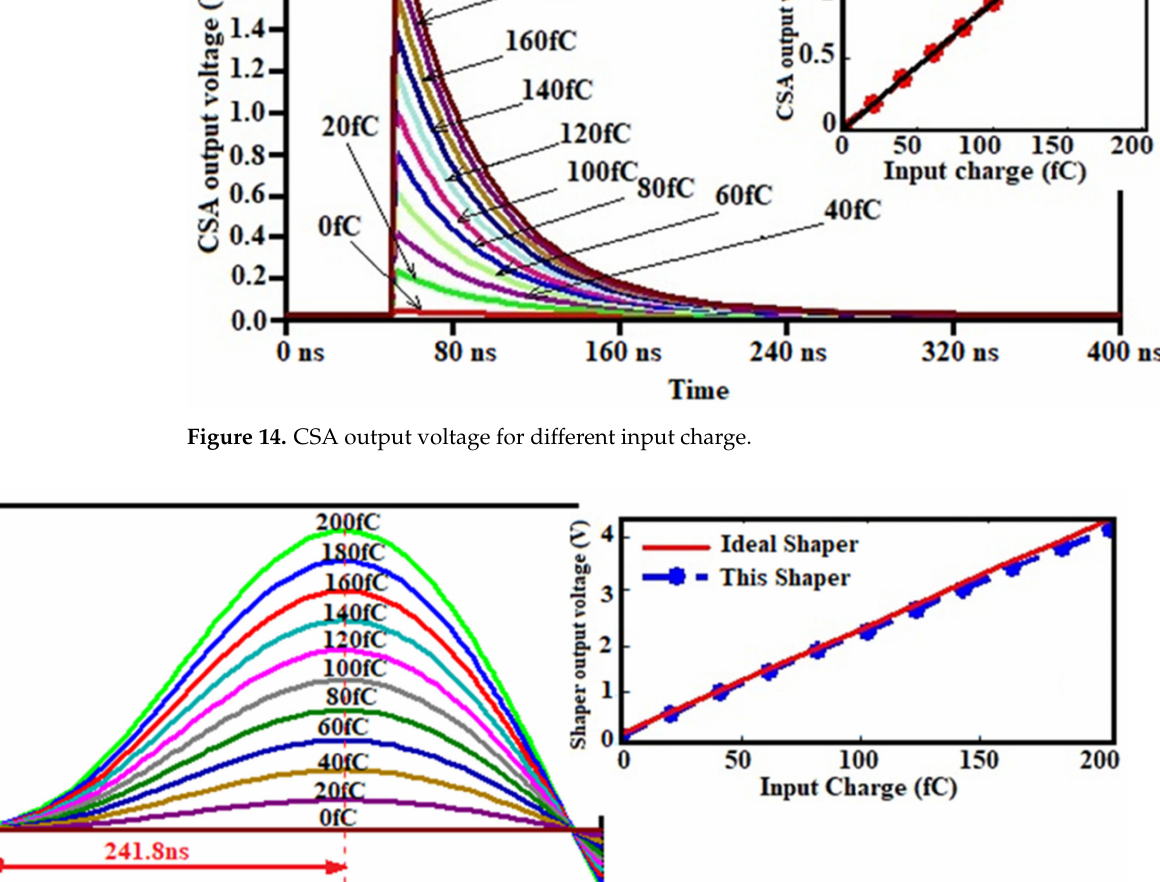
preamplifier input with 1 fC maximum step. The output swing of the circuit was computed and the histogram of the amplitude was therefore